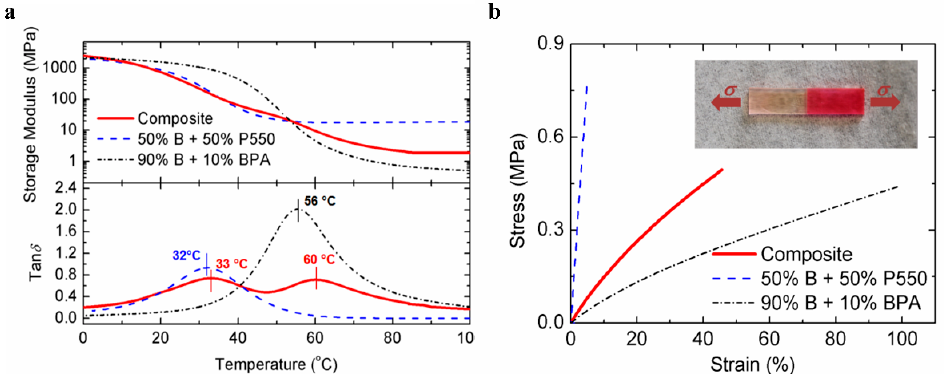
Figure 50. Thermomechanical tests to investigate the interface bonding within multi-material struc- tures (Material A = 50%B + 50%P550; Material B = 90%B + 10%BPA): ( a ) DMA and ( b ) uniaxial tensile tests of the composite and the single materials [61].